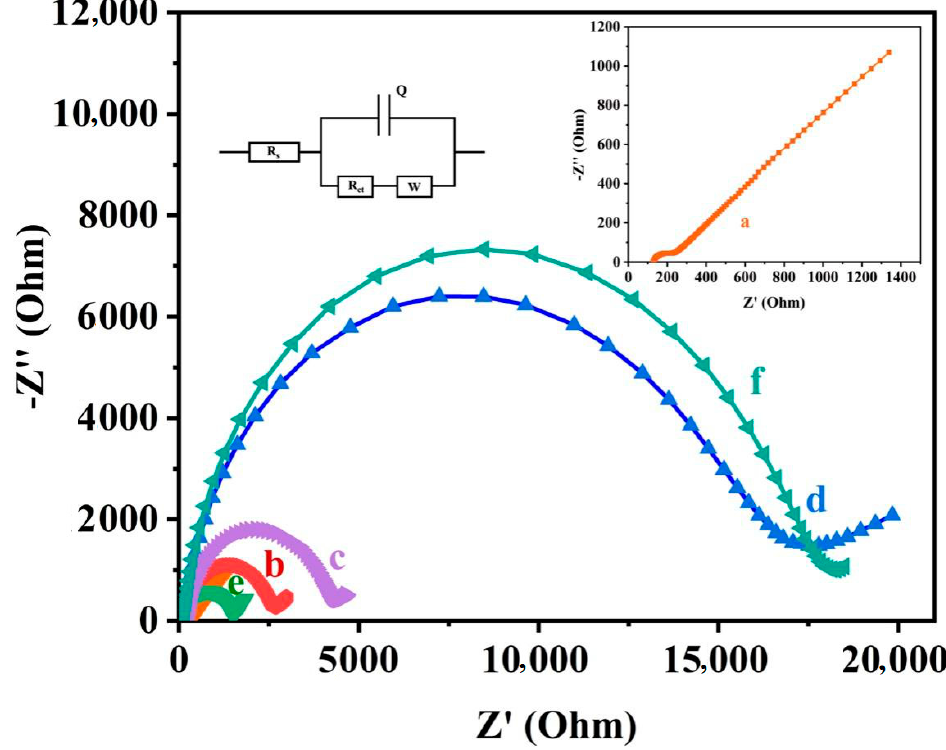
Figure 2. Nyquist plots at different stages of the modification process: ( a ) bare gold electrode; ( b ) B1-DNA, ( c ) M1-Biotin DNA, ( d ) M1-Biotin-SA DNA-modified electrode hydrolyzed by EXO III, ( e ) M1-Biotin DNA-modified electrode hydrolyzed by EXO III, ( f ) M1-Biotin-SA DNA-modified electrode. The data were recorded in the presence of 5 mM [Fe(CN) 6 ] 3 − /4 − containing 0.1 mol/L KCl, upon application of a bias potential of 0.214 V a 5 mV alternating voltage was applied in the frequency range 1–100 kHz.